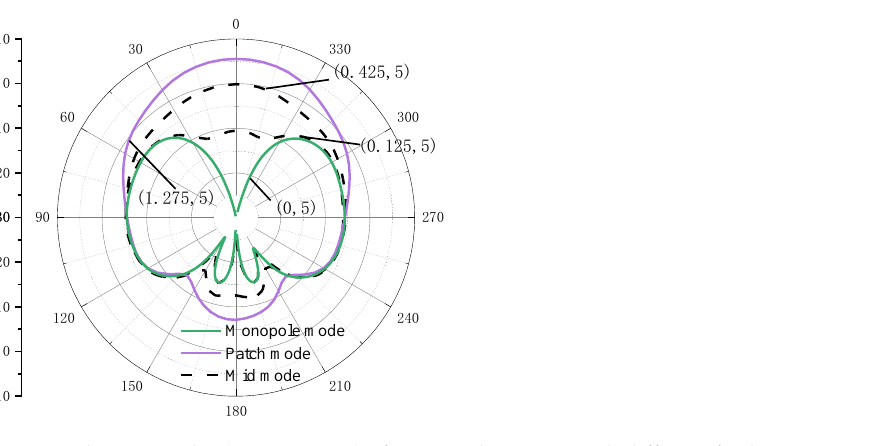
Figure 3. Radiation modes (at 12.12 GHz) of proposed antenna with different feeding positions. Unit: mm.